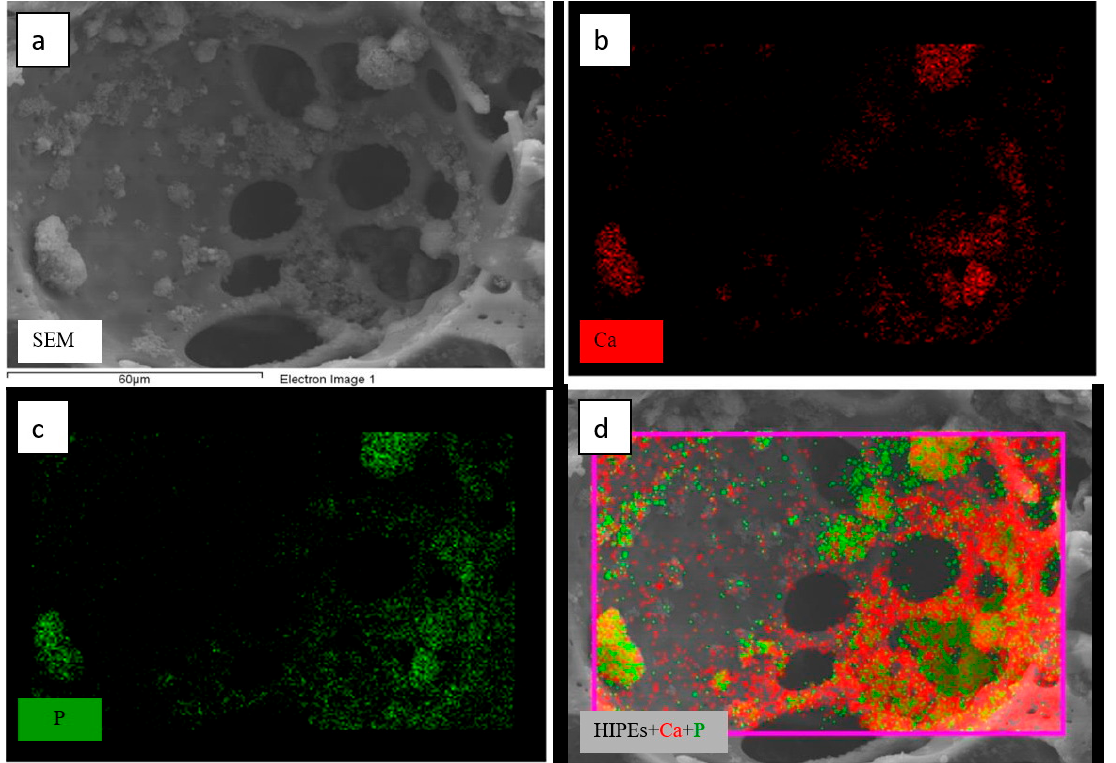
Figure 5. EDX mapping of poly(TT/DPEHA/HA)HIPEs containing 5-wt% hydroxyapatite. ( a ) SEM image of scanned region, ( b ) area map highlighting the presence of calcium shown in red, ( c ) area map highlighting the presence of phosphorus shown in green, ( d ) overlay map of calcium and phosphorus.